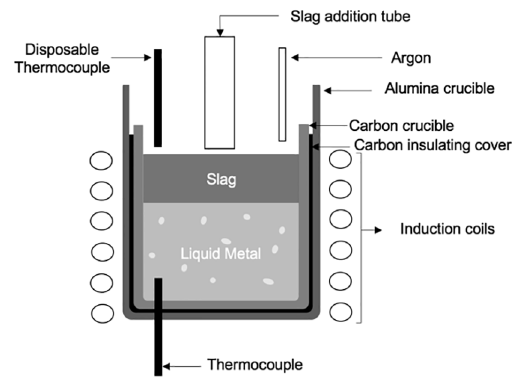
Figure 1. Schematic diagram of the induction furnace used in the